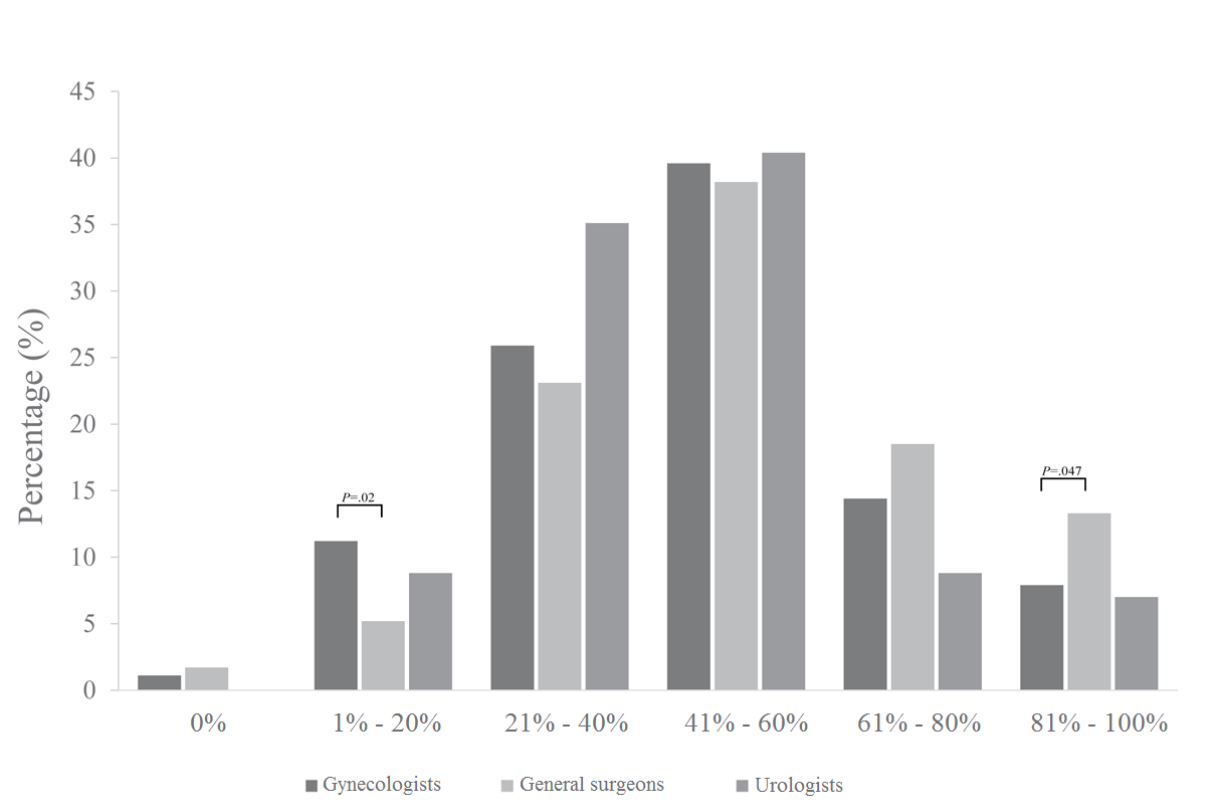
P valueUrologists